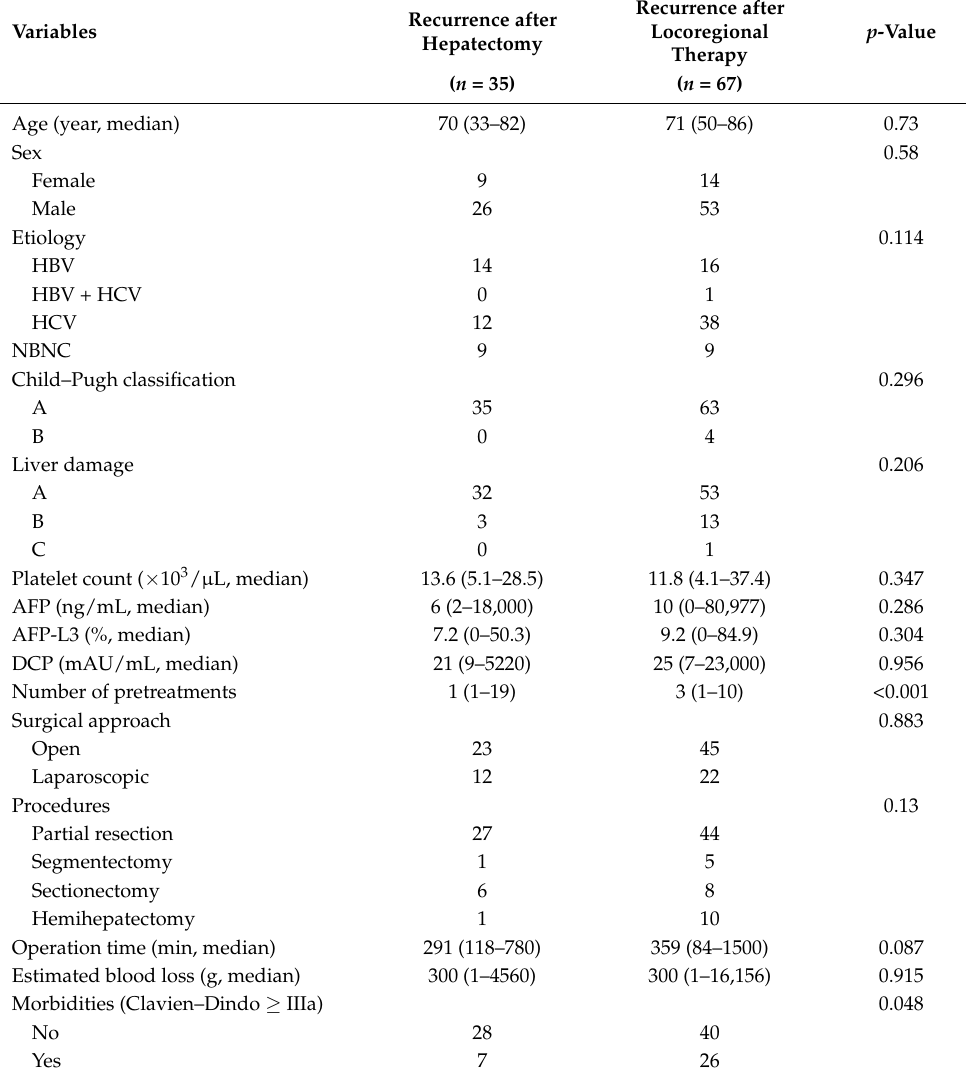
Table 1. Patient characteristics stratified by the previous treatment